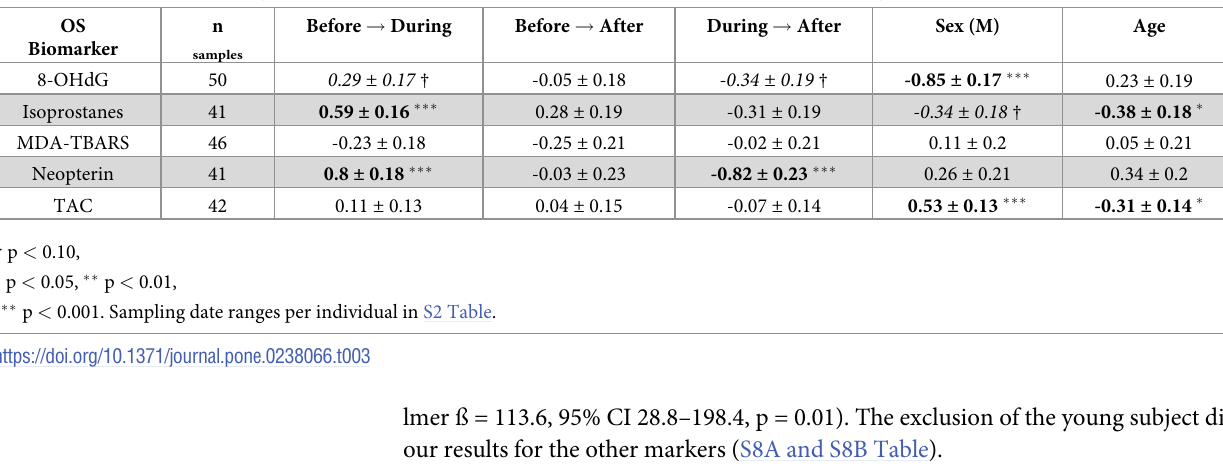
Table 3. Variation in OS biomarkers between periods of before, during, and after severe injury. Betas and standard deviations of contrasts from generalized linear mixed effects model and percentage of overall variance explained by individual ID as a random effect. Betas of significant contrasts in bold. n = 3 individuals (2 M, 1